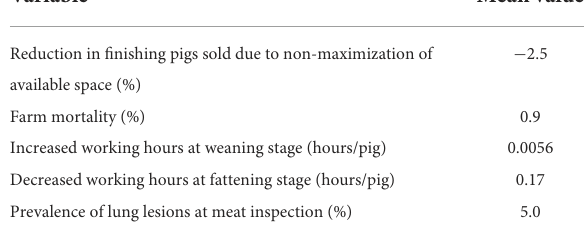
TABLE 2 Additional variables used in the partial budget analysis model for strategy S1 (avoiding mixing litters).